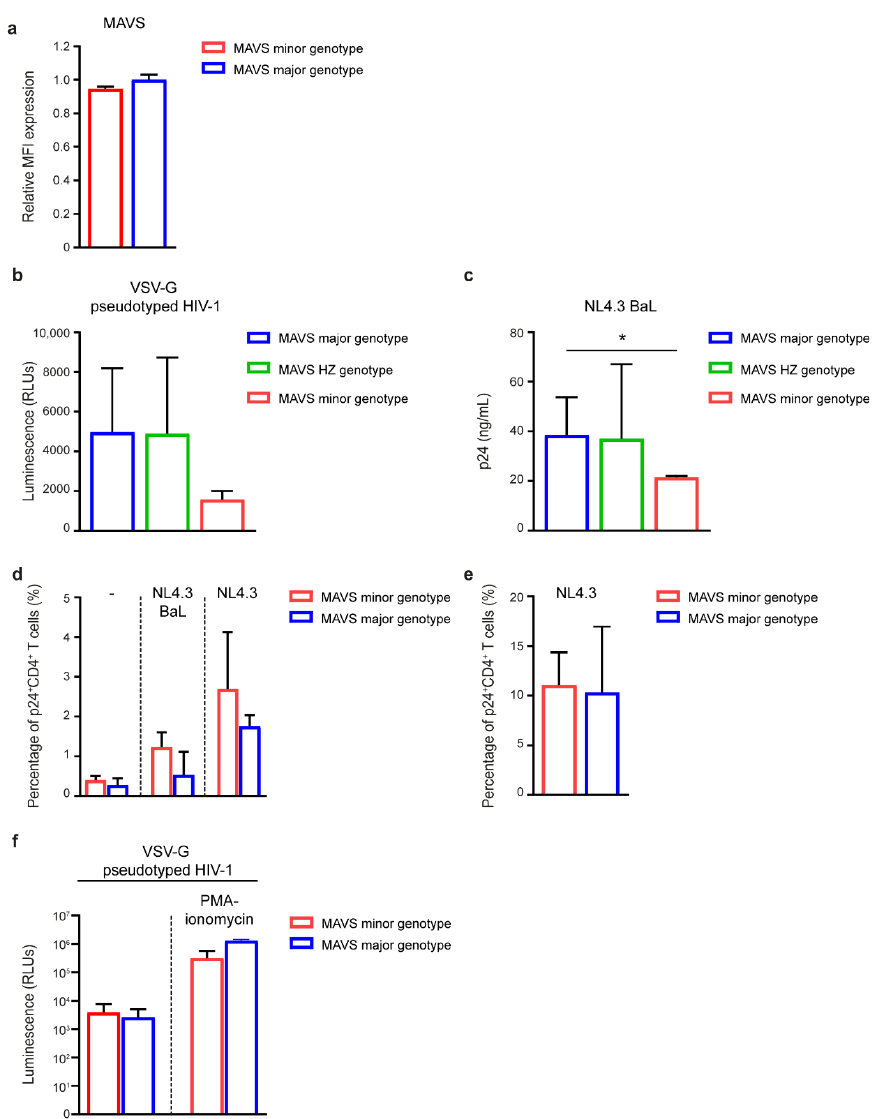
Figure 6. MAVS genotype a ff ects viral replication in vitro. ( a ) Relative mean fluorescent intensity (MFI) of intracellular MAVS protein expression in monocyte-derived dendritic cells determined by flow cytometry. ( b ) PBMCs of healthy donors with either a MAVS minor, MAVS heterozygous (HZ), or MAVS major genotype were infected with single round VSV-G-pseudotyped HIV-1 containing a fire-fly luciferase gene. After 72 h, luminescence was measured by relative light units (RLUs). ( c ) PBMCs of healthy donors with the di ff erent MAVS genotypes were infected with R5 tropic strain NL4.3 BaL. After 8 days, virus production was determined by the detection of Gag p24 in the supernatant using ELISA. ( d ) CD4 + T cells of healthy donors with the di ff erent MAVS genotypes were not infected, infected with R5-tropic strain NL4.3 BaL or X4-tropic strain NL4.3 or ( e ) pre-treated with phorbol myristate acetate (PMA) and ionomycin followed by NL4.3 infection. After 8 days, virus replication was determined by the detection of intracellular Gag p24 using flow cytometry. ( f ) CD4 + T cells of healthy donors with the di ff erent MAVS genotypes were pre-treated with or without PMA and ionomycin followed by infection with single round VSV-G-pseudotyped HIV-1 containing a fire-fly luciferase gene. After 72 h, luminescence was measured and results are given as relative light units (RLUs). Data are representative of four ( a ), 25 ( b ), 24 ( c ) or three ( d – f ) MAVS major individuals, five ( b , c ) MAVS heterozygous individuals and four ( a ), two ( b – f ) MAVS minor individuals (median ± IQR). All significant di ff erences are indicated: * p < 0.05, unpaired Mann–Whitney